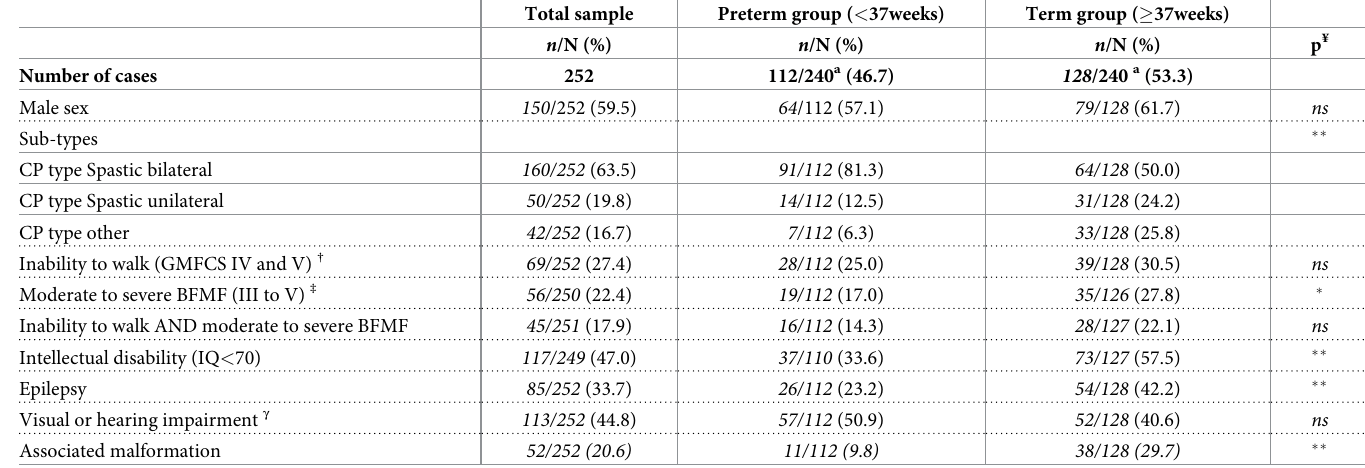
Table 2. Clinical characteristics, indicators of severity and associated disorders of children with CP born between 2000 and 2011 according to their term